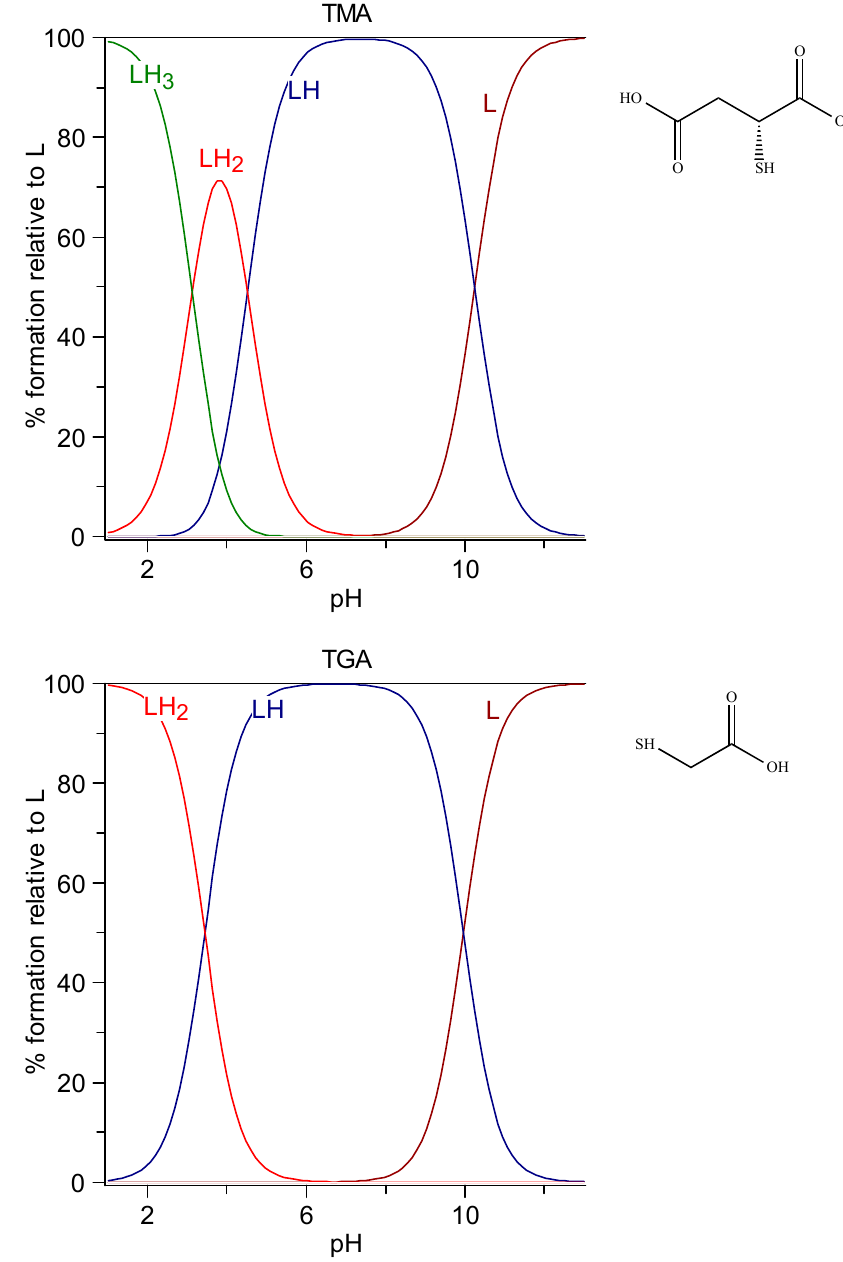
Figure 1. Speciation plots of TGA (top) and TMA (bottom).